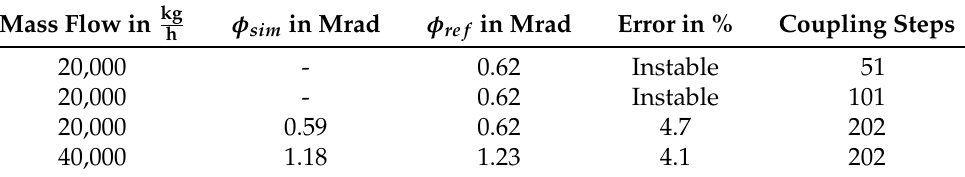
Table 6. Phase shift errors for different mass flows and coupling steps per